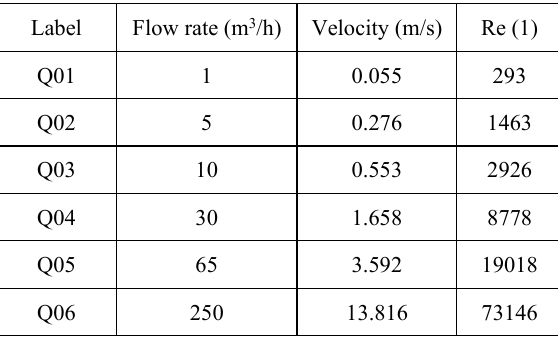
Table 1 Simulated flow rates.